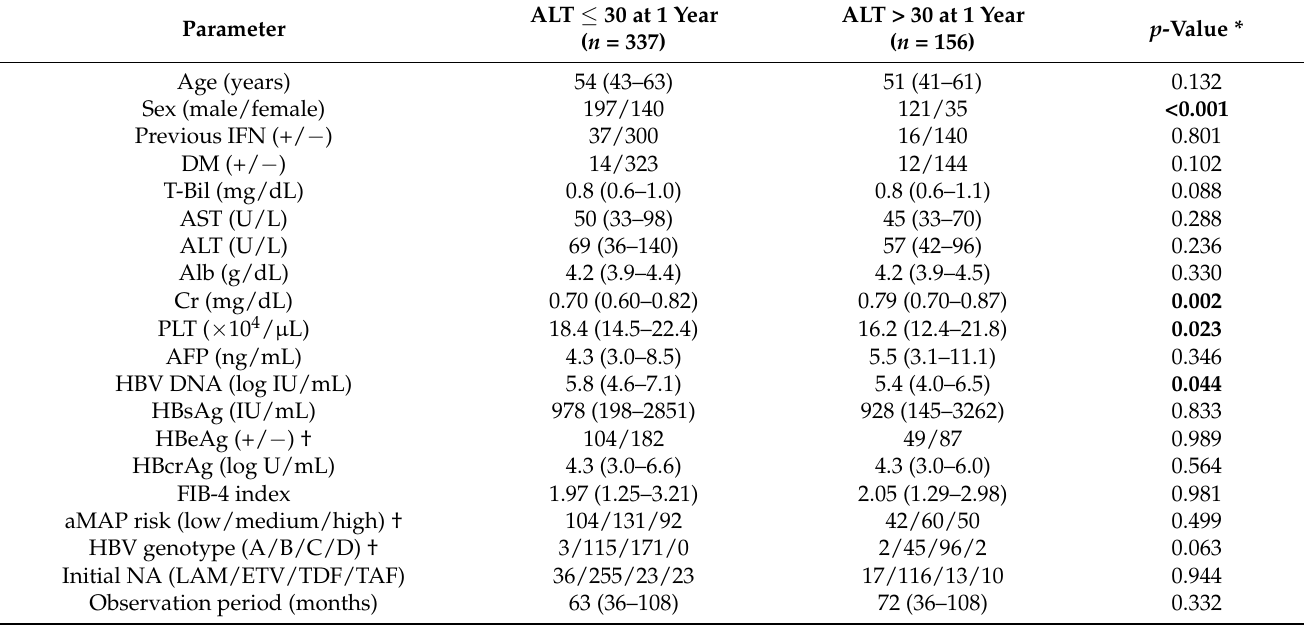
Table 3. Comparison of baseline characteristics between patients who achieved ALT normalization (JSH criteria, ≤ 30) and those who did not at 1 year of NA therapies. ALT ≤ 30 at 1 Year ALT > 30 at 1 Parameter ( n = 337)